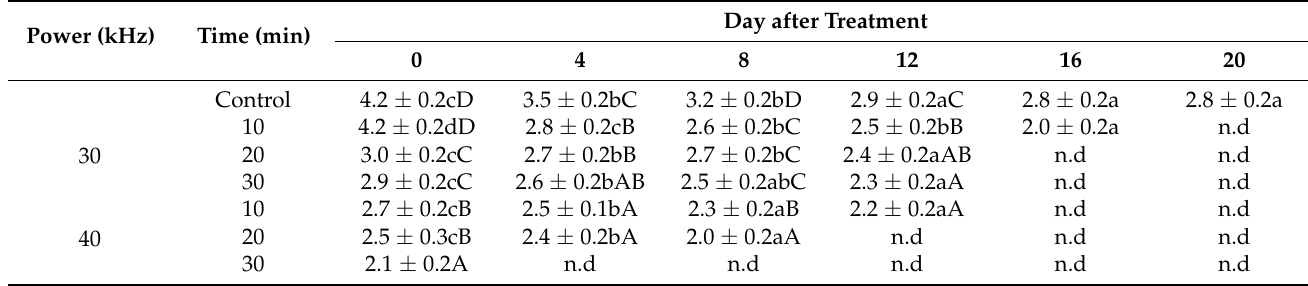
Data expressed as mean ± standard deviation of three repetitions. In the same row, different lowercase letters indicate statistically significant differences between treatment days ( p < 0.05). In the same column, different capital letters indicate statistically significant differences between the treatments ( p < 0.05). Legend n.d not